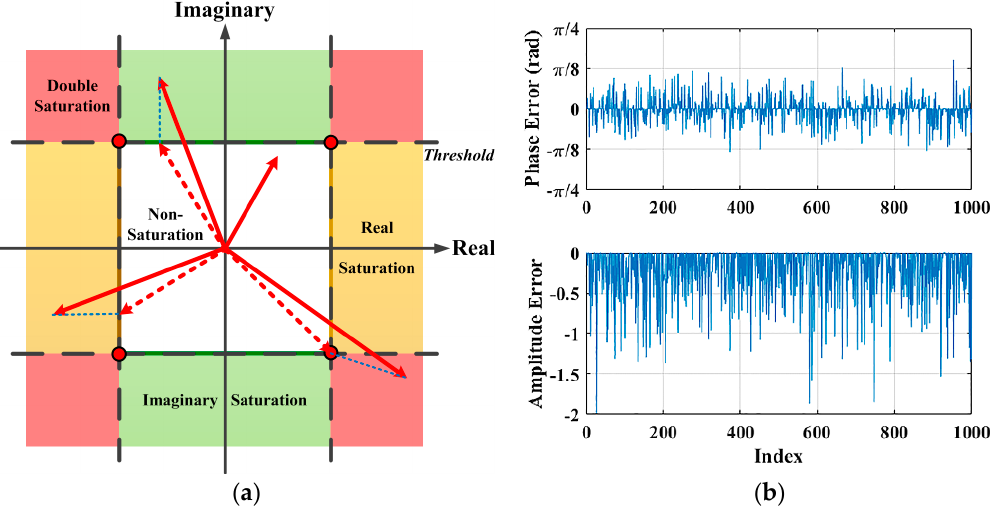
Figure 5. Phase and amplitude errors of raw data samples. ( a ) The solid red lines are input vectors, and the dotted red lines are outputs with ADC saturation. If the samples fall in the white area, there is no saturation at all. In the yellow area or green area, there is only real or imaginary saturation, and the output values are set on the four edges of the white square nearby. If the samples fall within the red area, saturation occurs in both the real and imaginary parts, and the output values are all set at the four red corners. ( b ) The phase errors and amplitude errors of a zero-mean complex Gaussian echo with a clipping factor of 30% and normalized mean power.